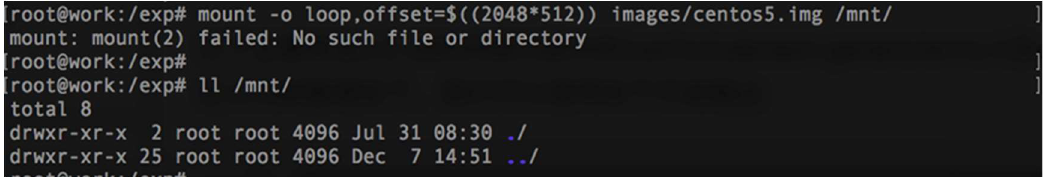
Figure 11. Mount and view the/boot partition of VM5, with PVMH enabled.